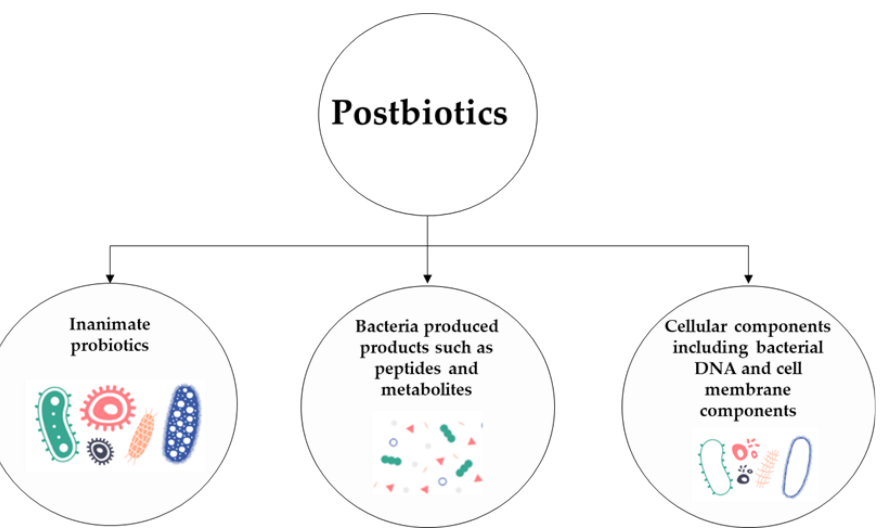
ferent mechanisms. These effects could be related to the activities of the inanimate probiotics, bac- terial components (i.e., lipoteichoic acid, peptidoglycans, bacteriocins, enzymes, nucleotides and/or peptides), and/or metabolites (such as short-chain fatty acids, SCFAs). These beneficial effects could be related to the activities of their components, includ-